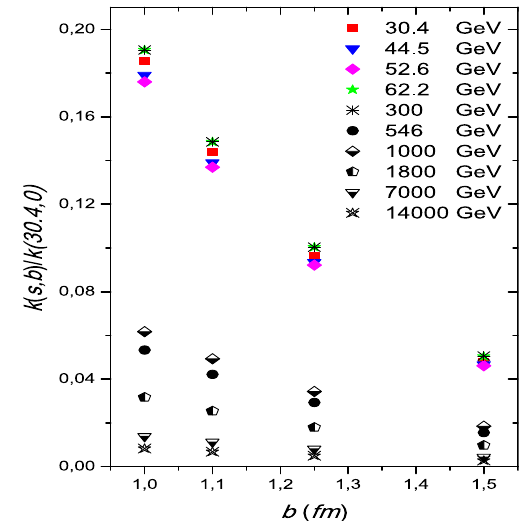
Fig. 10 Ratios K ( s , b )/ K ( 30 . 4 , 0 ) calculated for different collison energies and impact parameters values. The value of K ( 30 . 4 , 0 ) is 0.54, Fig. 1. The particle production processes tend to be more peripheral at the ISR specific energies of 30.4, 44.5, 52.6 and 62.2 GeV